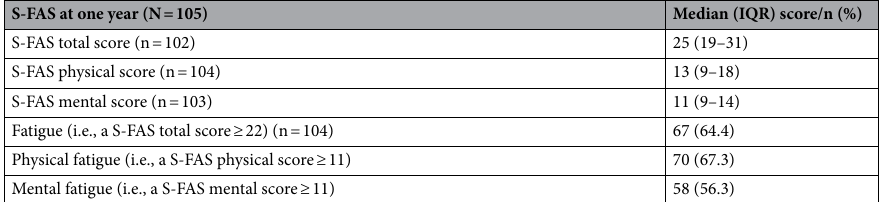
S-FAS at one year (N =